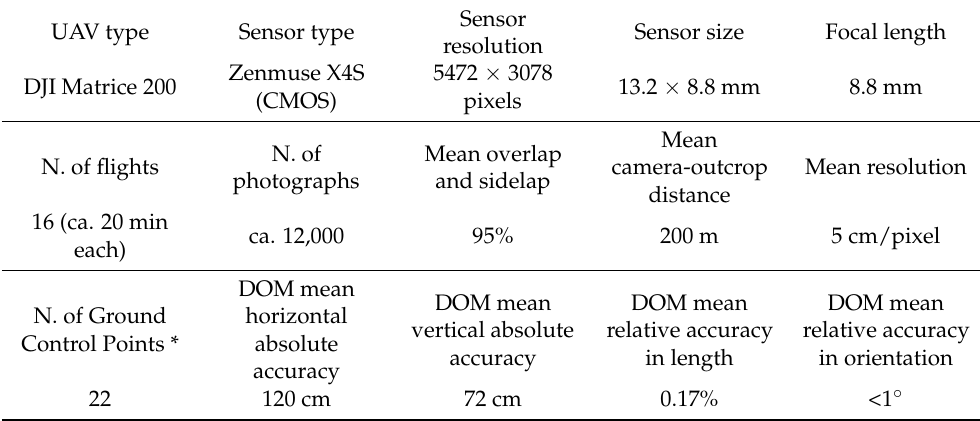
Figure 4. Perspective view of the Digital Outcrop Model (DOM) of the Lastoni di Formin, overlaying the 1 m resolution LiDAR (retrievable from [28]) colored according to the elevation (blue and red color correspond to lower and higher elevation, respectively). Table 1. Summary of the main specifications of UAV instrumentation, the photogrammetric survey, and the developed Digital Outcrop Model (DOM) accuracy.